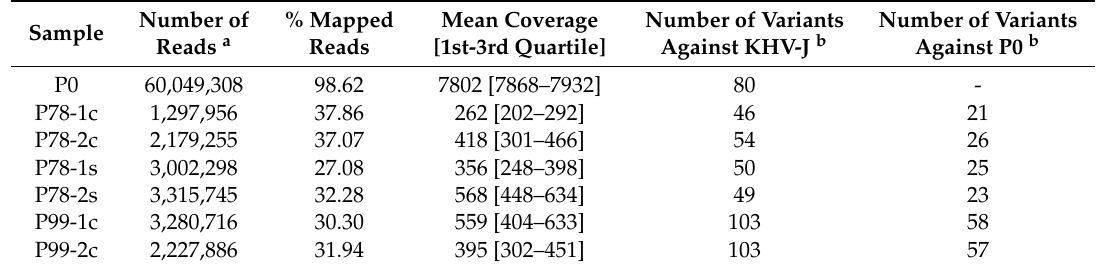
Table 2. Main features of genome